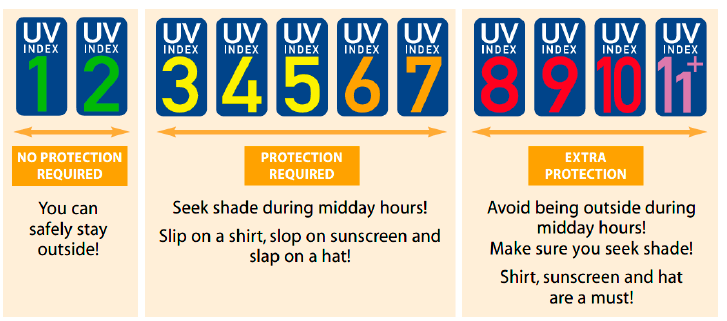
Figure 3. UV Index scale [43] .